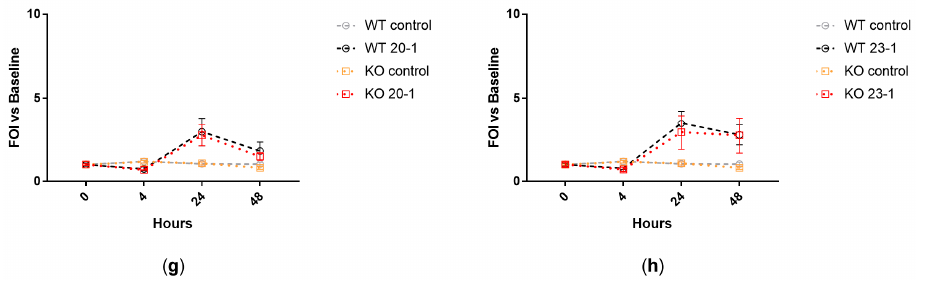
Figure 2. IL-8-dependent bioluminescence emi tt ed by WT and KO mice after intratracheal challenge with each clinical isolate: 2-4 ( a ), 7-2 ( b ), 8-2 ( c ), 12-2 ( d ), 16-1 ( e ), 17-1 ( f ), 20-1 ( g ), 23-1 ( h ). Imaging was performed before lung challenge (0 h) and after 4, 24, and 48 h. FOI = Folds of Induction vs. baseline (0 h). Each value represents the mean ± SEM of four animals. Statistical analysis of treated vs. control mice was performed by repeated measures 2-way ANOVA followed by Tukey’s multiple comparison test; *** p < 0.001, **** p < 0.0001.